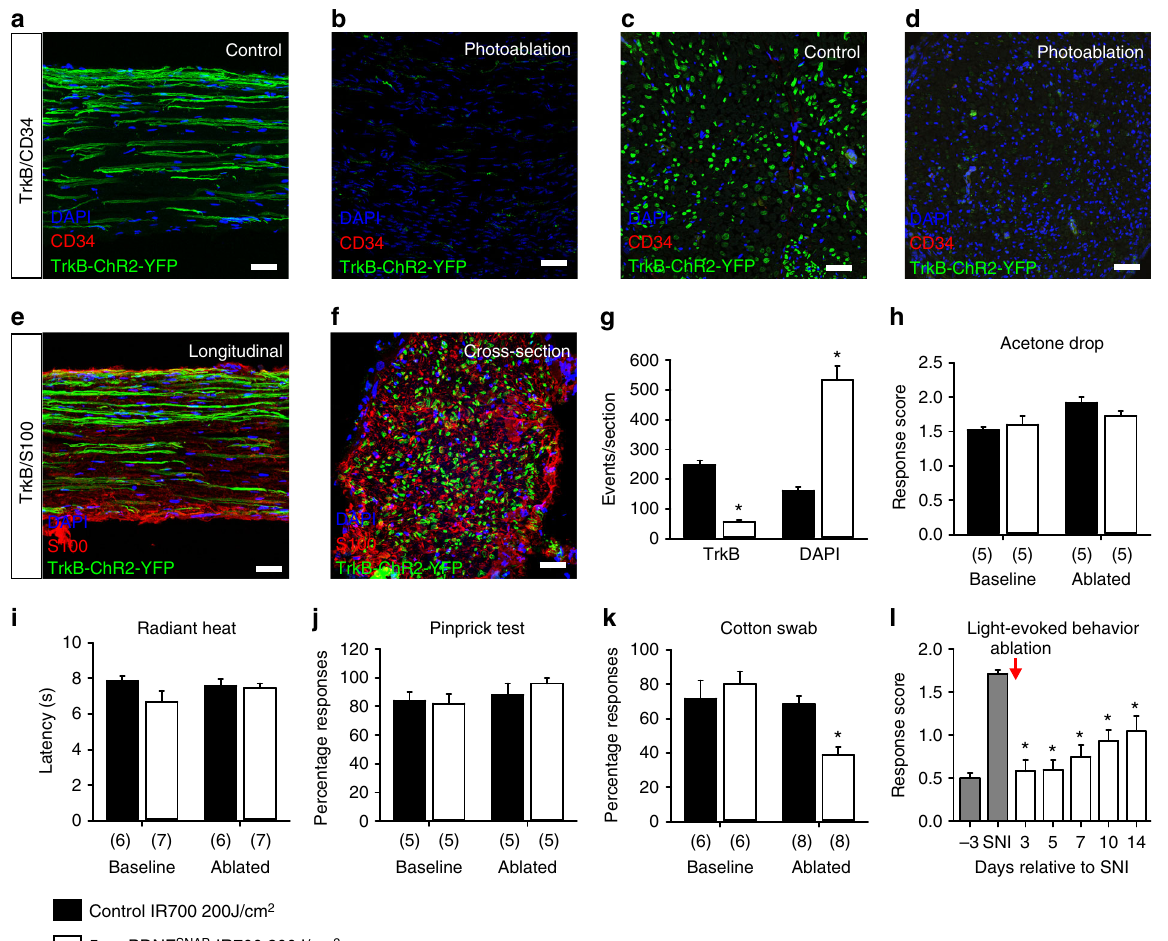
Fig. 7 Photoablation of the sciatic nerve shows requirement of TrkB + neurons in mediating allodynia. a – f Representative images of the sciatic nerve labeled for TrkB in green, DAPI in blue, and CD34 or S100 in red. Longitudinal sections of the nerve show reduction in TrkB + fi bers, but no detectable CD34 in a non-ablated control and b photoablated mice. Cross-section of the sciatic nerve from c control and d photoablated mice shows reduction in TrkB + fi bers. No co-localization between TrkB + fi bers and S100 + cells in e longitudinal sections and f cross-section of the nerve. g Quanti fi cation of the numbers of TrkB + fi bers and DAPI labeled cells in cross sections of sciatic nerve. Behavioral sensitivity following BDNF SNAP -IR700-mediated ablation in the sciatic nerve: h acetone drop test ( t -test; p = 0.151), i radiant heat test ( t -test; p = 0.829), and j pin-prick test ( t -test; p = 0.548) are not altered by nerve photoablation. However, sensitivity to k cotton swab ( t -test; p = 0.001) in control animals, and l light-evoked behavior in TrkB CreERT2 ::Rosa26 ChR2 mice with SNI, are reduced by nerve photoablation (two-way RM ANOVA; p = 0.002). White bars 5 µ M BDNF SNAP -IR700 at 200 J/cm 2 , black bars 5 µ M IR700 at 200 J/ cm 2 . Baseline indicates pre-ablation and pre-treatment. Error bars indicate SEM. Scale bars, a – d 40 μ m, e 10